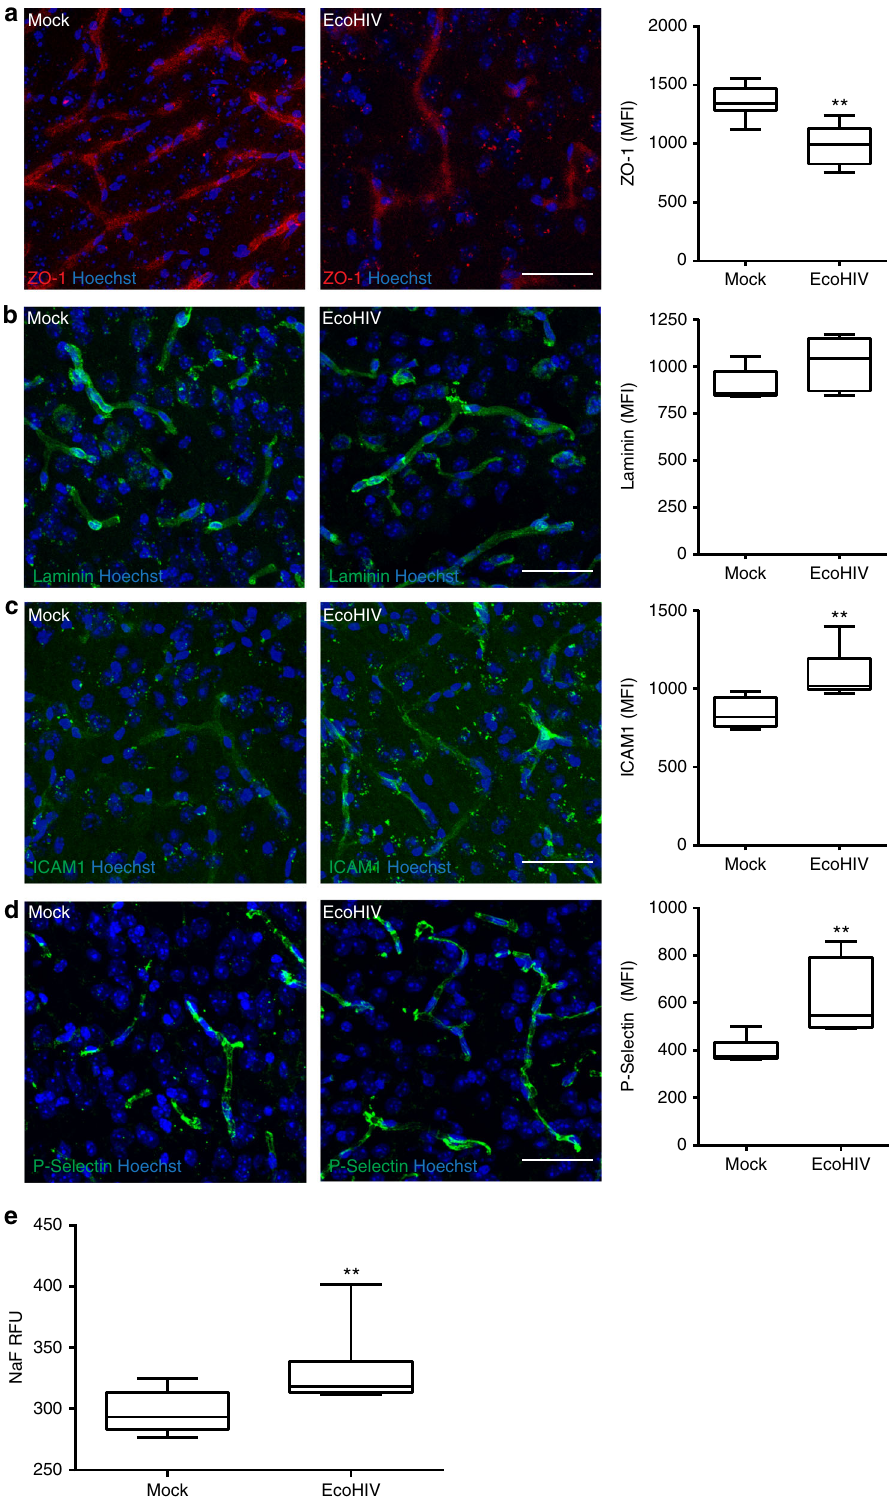
Fig. 2 Disruption of NVU and in fl ammatory responses in EcoHIV-infected brains. Mice were infected as in Fig. 1, and analyses were performed 3 weeks post infection. Brain sections were stained for ZO-1 ( a ), laminin ( b ), ICAM-1 ( c ), and P-selectin ( d ). In a , b , n = 6 mice, 20 microvessels per mice, 2 independent experiments. In c , d , n = 6 mice per group, 10 microvessels per mice, 2 independent experiments. e BBB permeability in mock- and EcoHIV-infected mice as assessed by the sodium fl uorescein (NaF) extravasation method; n = 10 per group, 2 independent experiments. Whiskers-box plots represent centerline median, with interquartile range and min-max whiskers. Source data are provided as a Source Data fi le. ** p < 0.01 vs mock; unpaired t test. a – d Scale bars: 40 µ